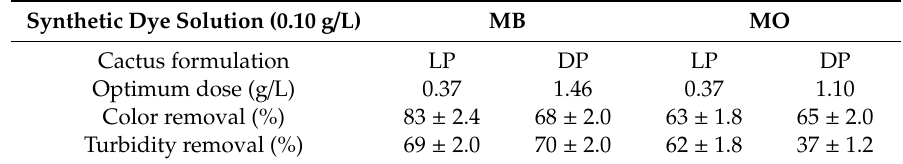
Table 5. MB and MO color and turbidity removals using cactus formulations as flocculants after a coagulation